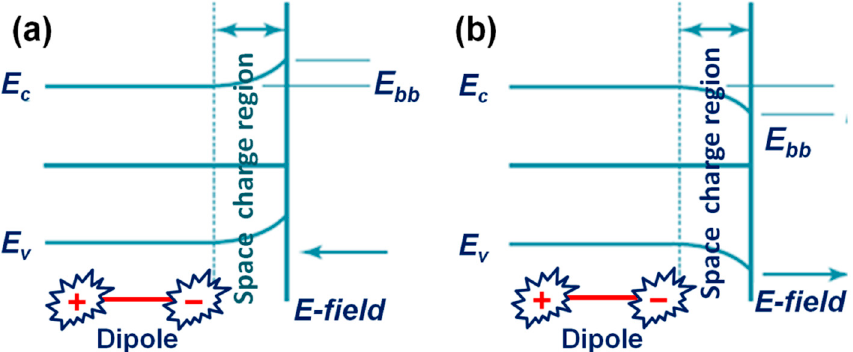
Figure 11. Schematic diagram of band bending in a ferroelectric material; ( a ) a surface with negative polarity and ( b ) a surface with positive polarity.